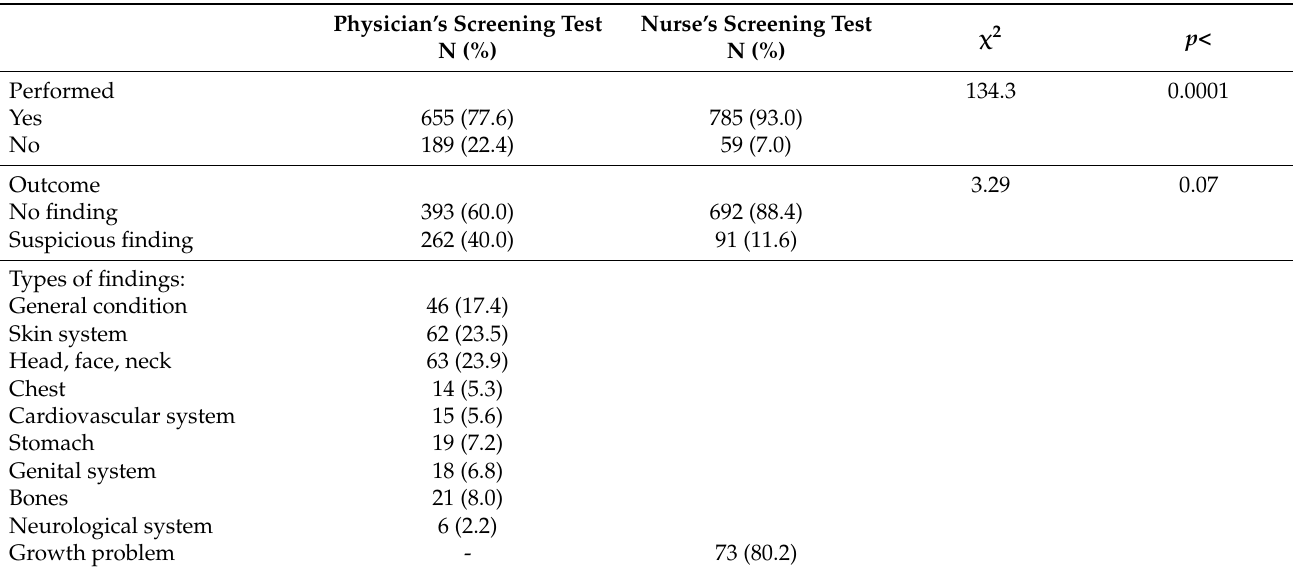
Table 2. Screening test outcomes for the 2016–2017 cohort, physicians and